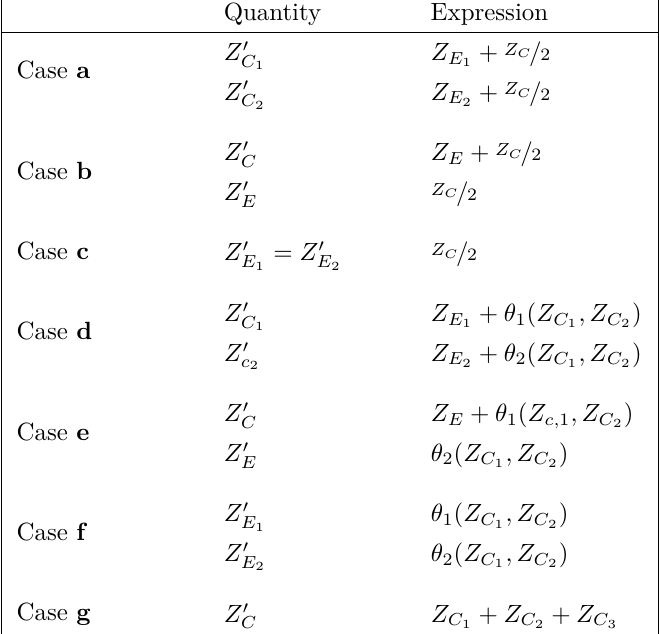
for the different X 0